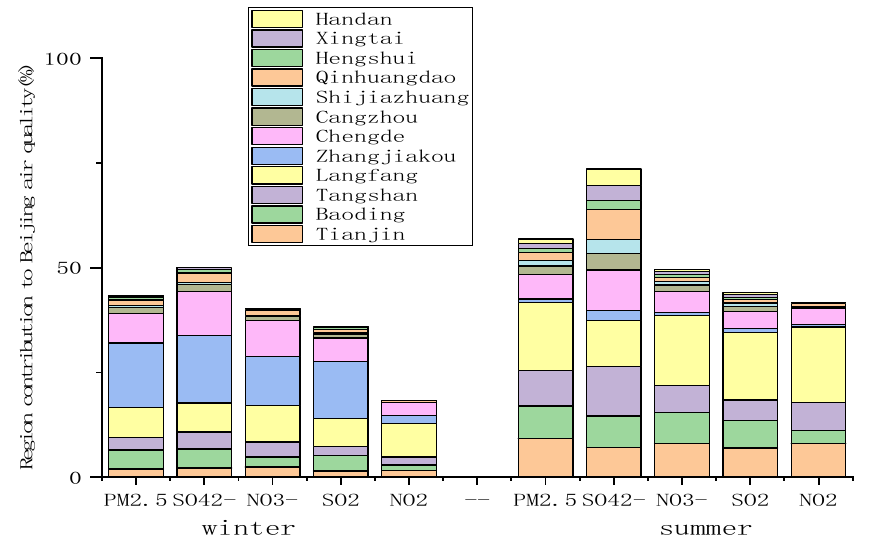
Figure 9. Regional sensitivity coefficients for Beijing.